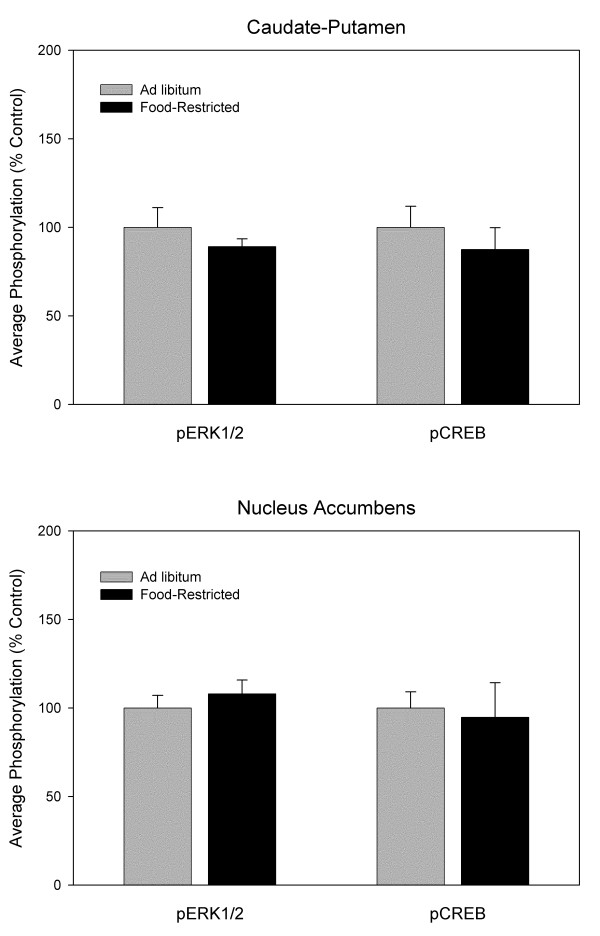
Basal levels of phospho-ERK1/2 and -CREB in Caudate-Putamen and Nucleus Accumbens Ad libitum fed and food-restricted rats that were not implanted with i.c.v. cannulas were sacrificed without receiving experimental treatment. Lysates were immunoblotted with anti-phospho ERK1/2 or anti-ERK1/2, and anti-phospho-CREB or anti-CREB antibodies. Following densitometry, intensities of bands corresponding to phosphorylated proteins were divided by intensities of the corresponding total protein bands to correct for small differences in protein loading. Results (mean ± S.E.M.) for caudate-putamen (top) and nucleus accumbens (bottom) are expressed in comparison to the normalized control, which was defined as the ad libitum fed group.